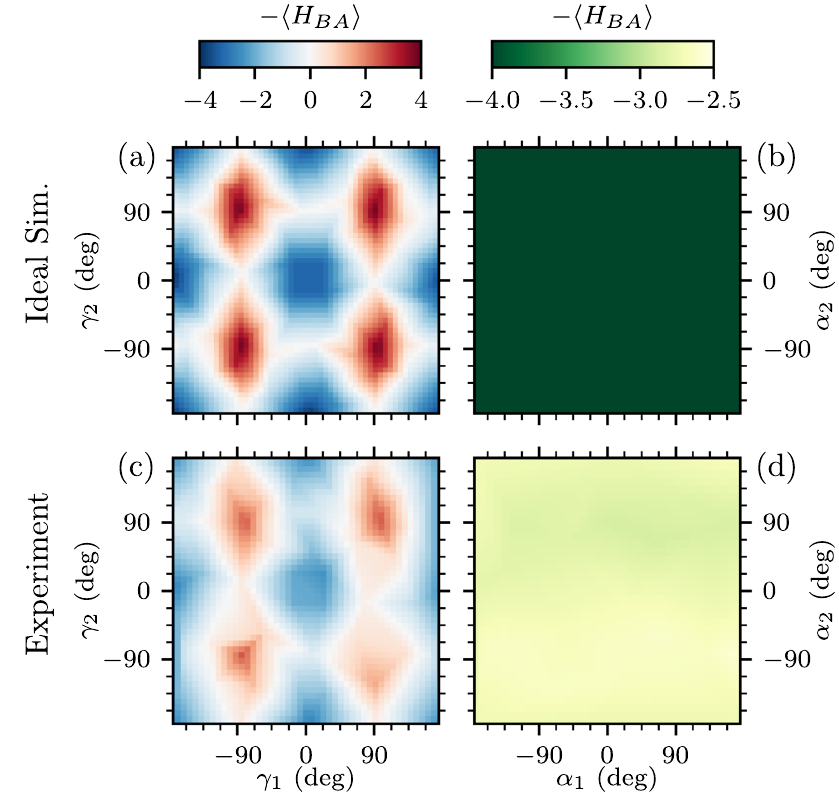
Fig. 3 Landscape of the cost function for in fi nite temperature. Panels ( a ) and ( c ): Landscape cuts obtained in noiseless simulation and in experiment, respectively, when varying control angles γ while keeping α = 0 (the ideal solution value). Panels ( b ) and ( d ): Corresponding cuts obtained when varying control angles α while keeping γ = 0 (the ideal solution value). See text for details. These landscape cuts are sampled at 100 points and interpolated using the Python package adaptive 41